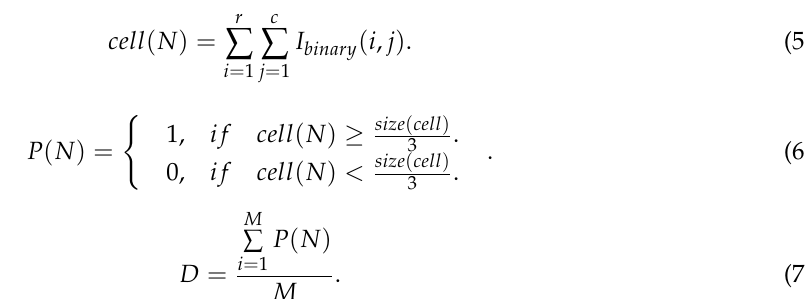
Figure 4. Local scene partition method for scene characteristic classification.